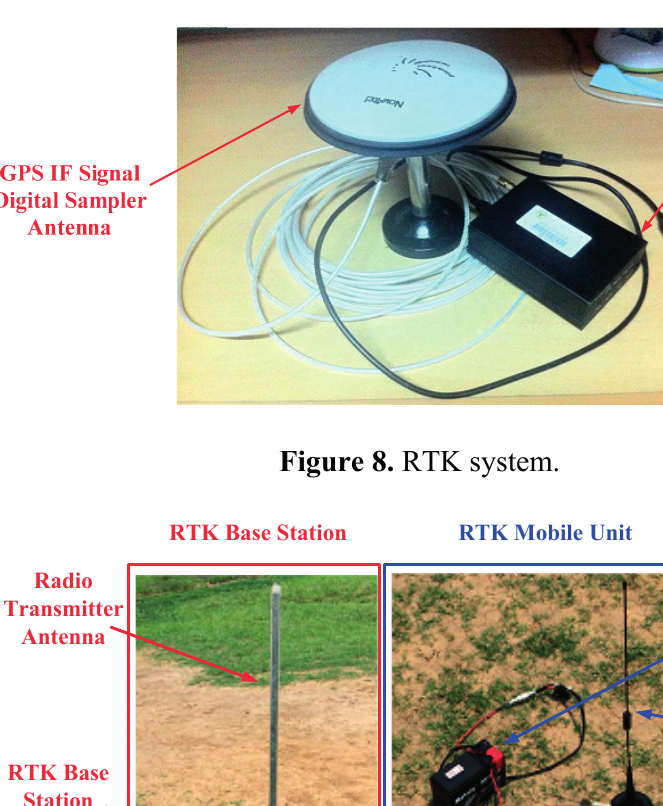
Figure 7. GPS IF signal digital sampler.